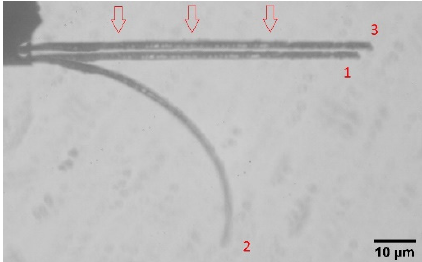
Figure 3. Combined image of the crystal at three different moments of transformation at λ = 350 nm: (1)—initial state of the crystal, (2)—position of maximum bending (after 15 min of irradiation), (3)—final shape of the completely transformed crystal (80 min of irradiation, the image is shifted vertically up). The arrows indicate the direction of light.